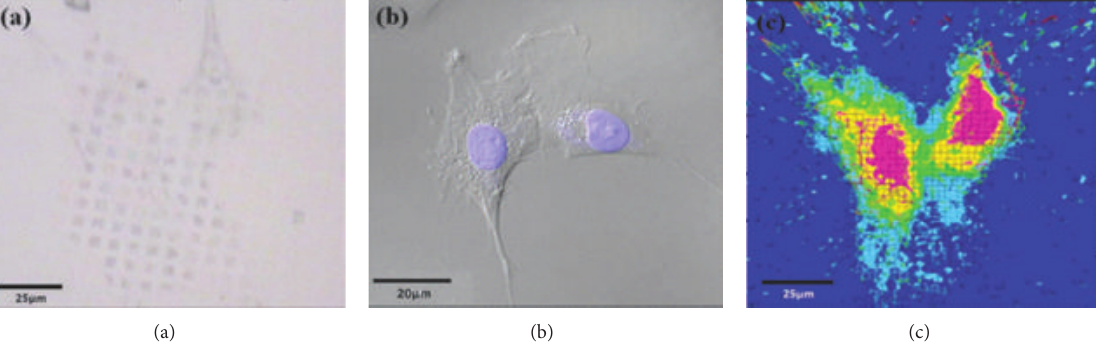
Figure 8: (a) The unlabeled optical microscopic image of hMSCs on the SRR substrate. (b) The confocal fluorescent microscopic image of the hMSCs. (c) The intracellular image of the hMSCs by the SRR platform [43].